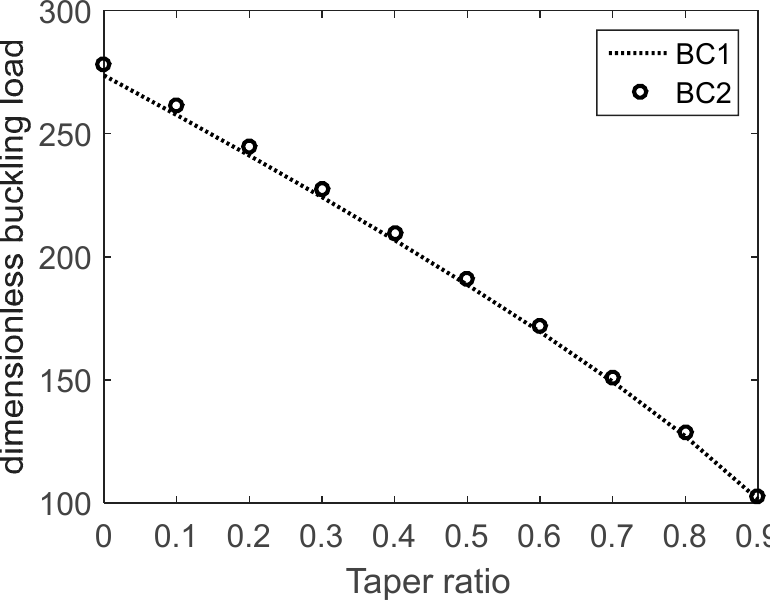
Figure 5. Effects of nonclassical boundary conditions on the dimensionless buckling load of propped cantilever microbeams corresponding to various taper ratios ( n = 1, l L = h 1